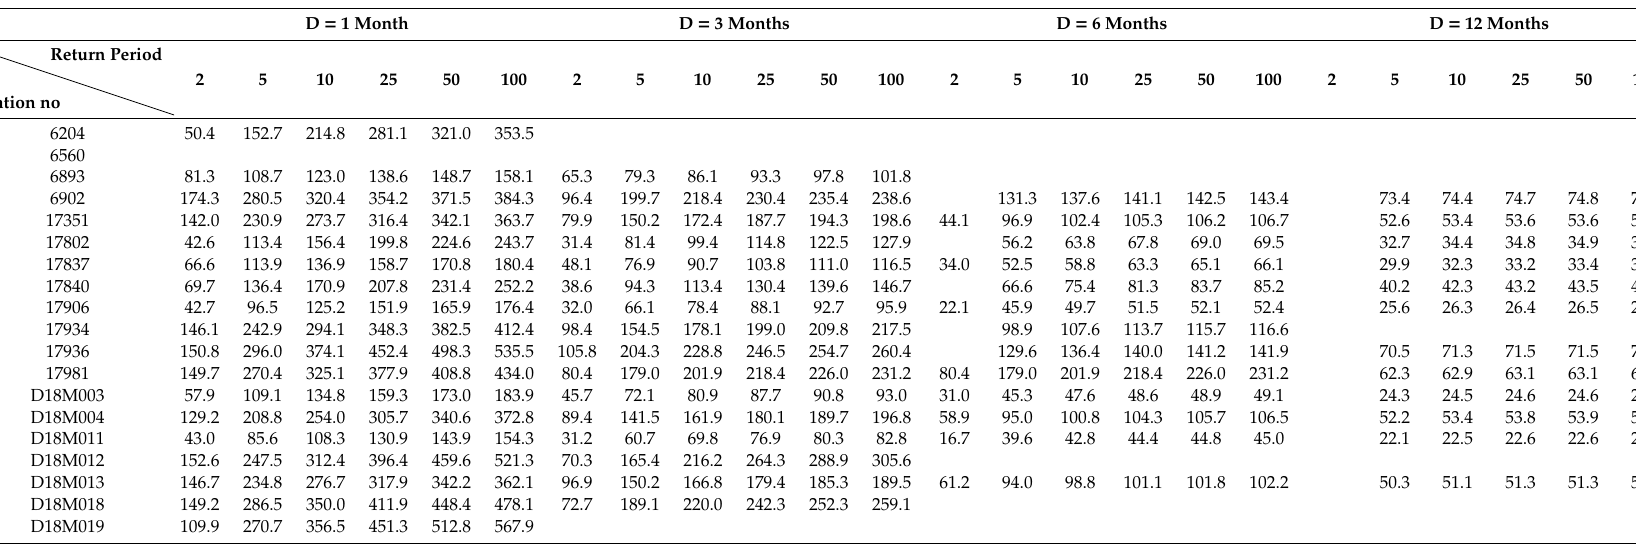
Table 2. Drought intensity based on precipitation deficit corresponding to 2, 5, 10, 25, 50 and 100-year return periods at k = 12-month time